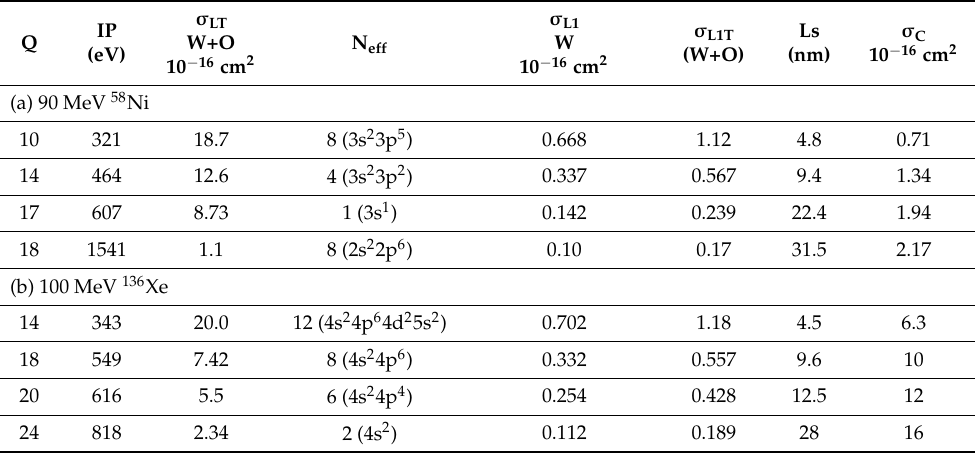
Table 5. (a) Data of 90 MeV Ni Q for ion charge of Q in WO 3 relevant to this study. Total electron loss cross section ( σ LT ) after [62], single electron loss cross section ( σ L1 ) after [63,64] and single electron capture ( σ C ) [68] in 10 − 16 cm 2 . IP is the first ionization potential for Ni Q state [65] and N eff is